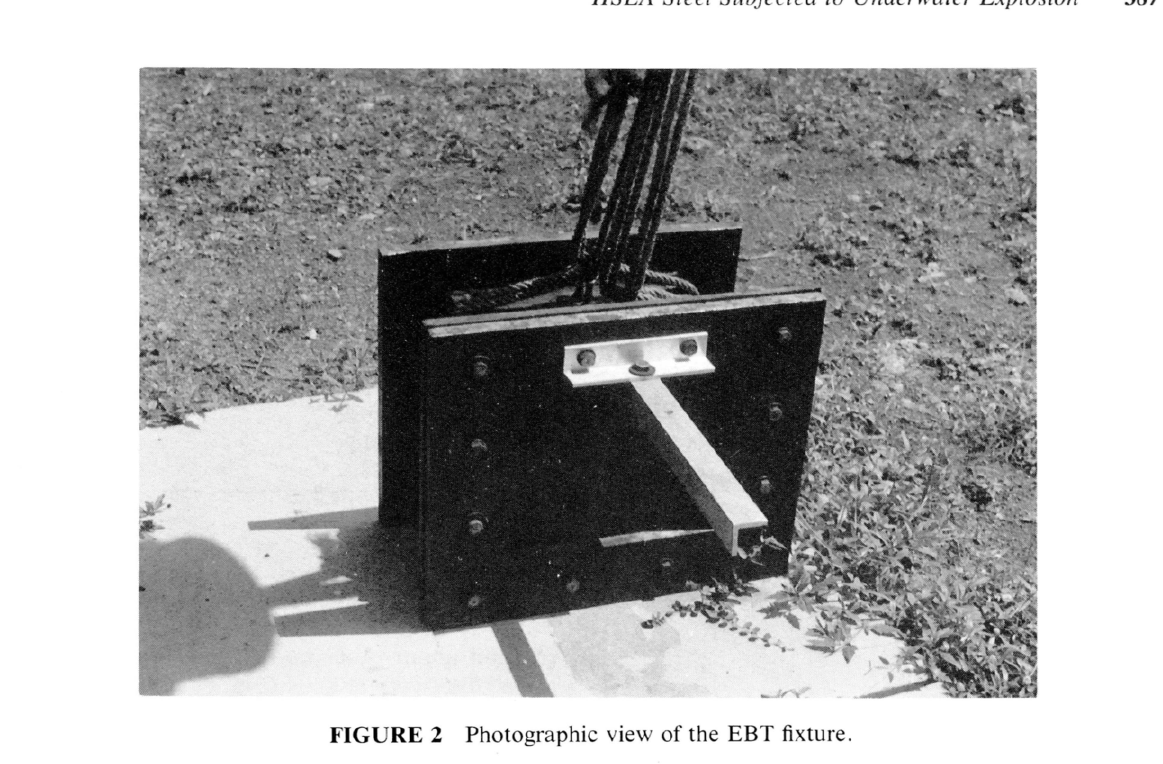
FIGURE 2 Photographic view of the EBT fixture.